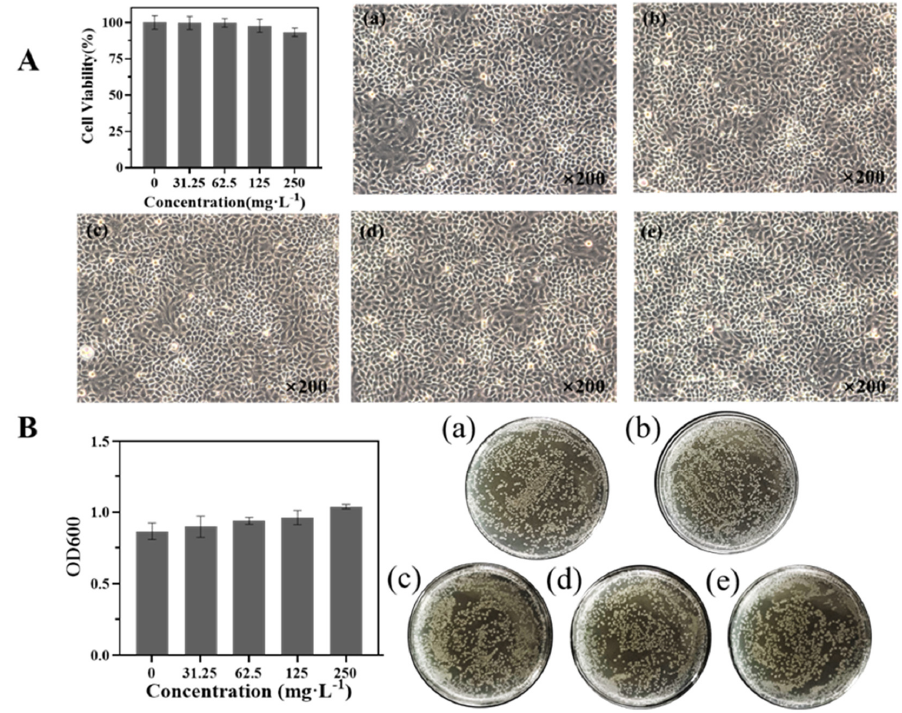
Figure 10. Biosafety evaluation of BMMs − SS − Py/ β− CD NPs against ( A ) 16HBE cells and ( B ) E. coli with the concentrations of ( a ) 0 mg·L − 1 , ( b ) 31.25 mg·L − 1 , ( c ) 62.5 mg·L − 1 , ( d ) 125 mg·L − 1 , and ( e ) 250 mg·L − 1.